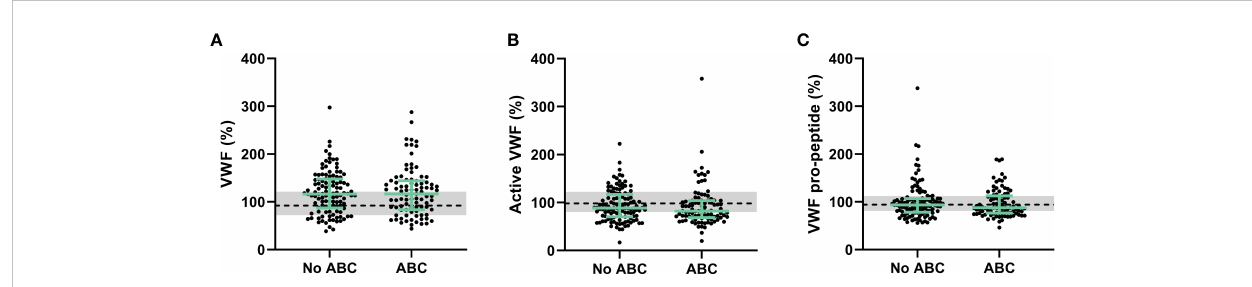
FIGURE 2 Von Willebrand factor as a biomarker of endothelial wall function in PLHIV, strati fi ed for ABC treatment. (A-C) Von Willebrand Factor (A) , active Von Willebrand Factor (B) and Von Willebrand Factor pro-peptide (C) levels did not differ between PLHIV on ABC-based or non-ABC-based treatment, and between PLHIV and controls without HIV. Data of PLHIV with and without ABC-based treatment are represented as dots with green bars indicating the group median and interquartile range. For comparison, the median of the controls without HIV is shown as a black dashed line and the interquartile range is depicted as a grey box. ABC, abacavir; PLHIV, people living with HIV; VWF; Von Willebrand